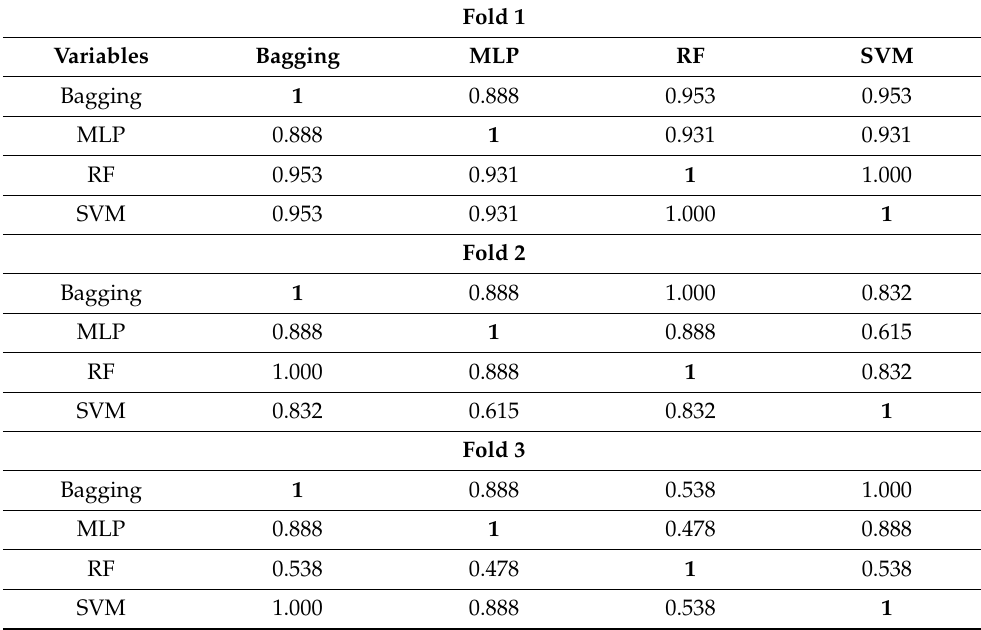
Table 3. Correlation matrix of the classifiers depicting the degree of correlation in terms of M